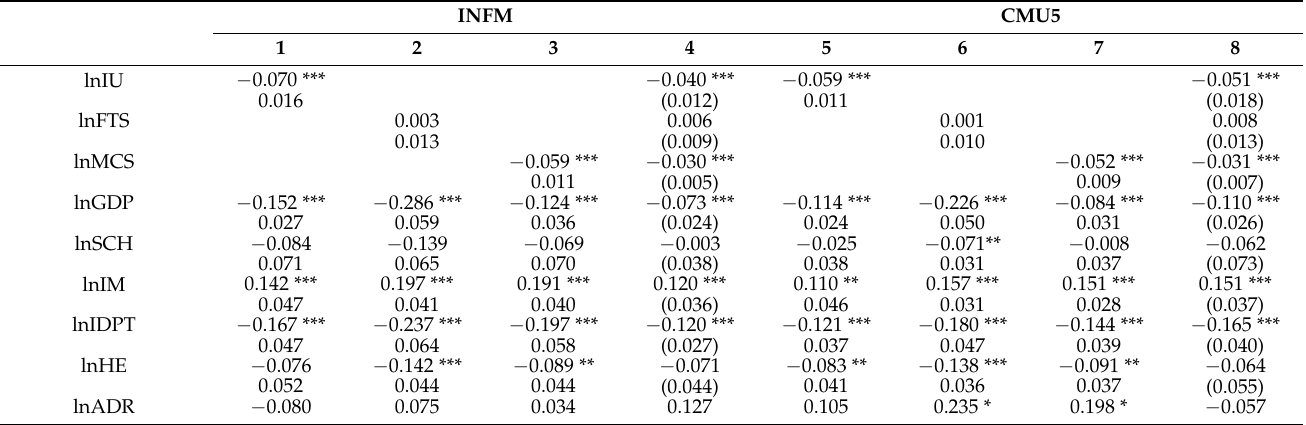
Table 3. FE using Driscoll–Kraay robust error estimation results for infant mortality and child mortality under